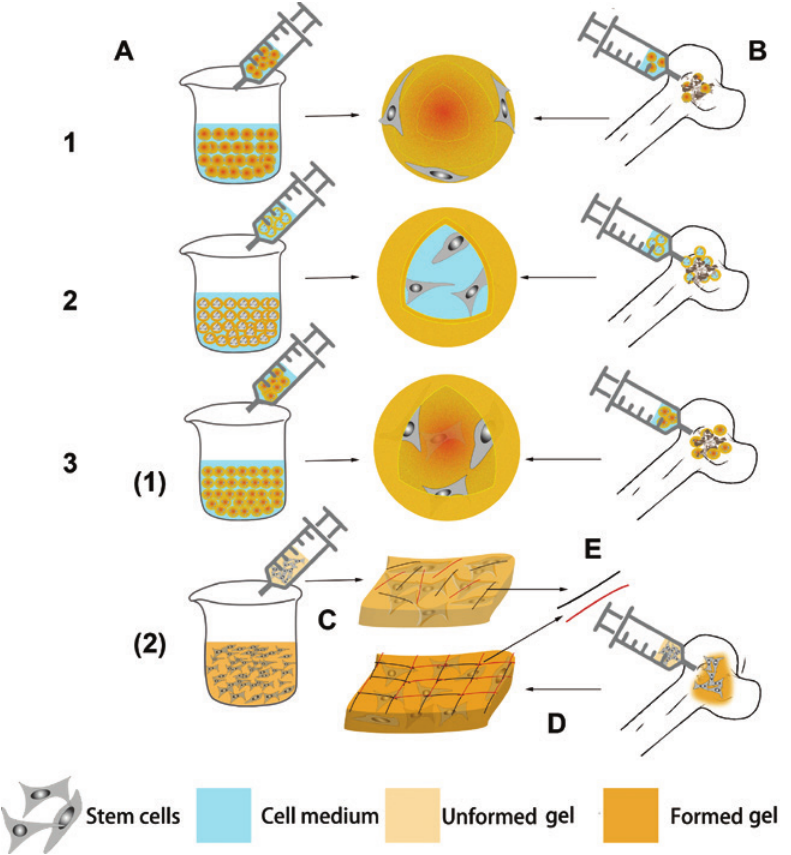
Figure 1: The classification of hydrogel based carriers. 1. Surface immobilization. 2. Microencapsulation. 3 Matrix entrapment: (1) Microgel or other particles. (2) In situ forming hydrogel. A. Before injection. B. After injection. C. In situ forming hydrogel in solution form. D. In situ forming hydrogel in gel form. E. Component chains of in situ forming hydrogel, before cross-linking, they are independent and after they crosslink uniformly with each other. Adapted from Ref.